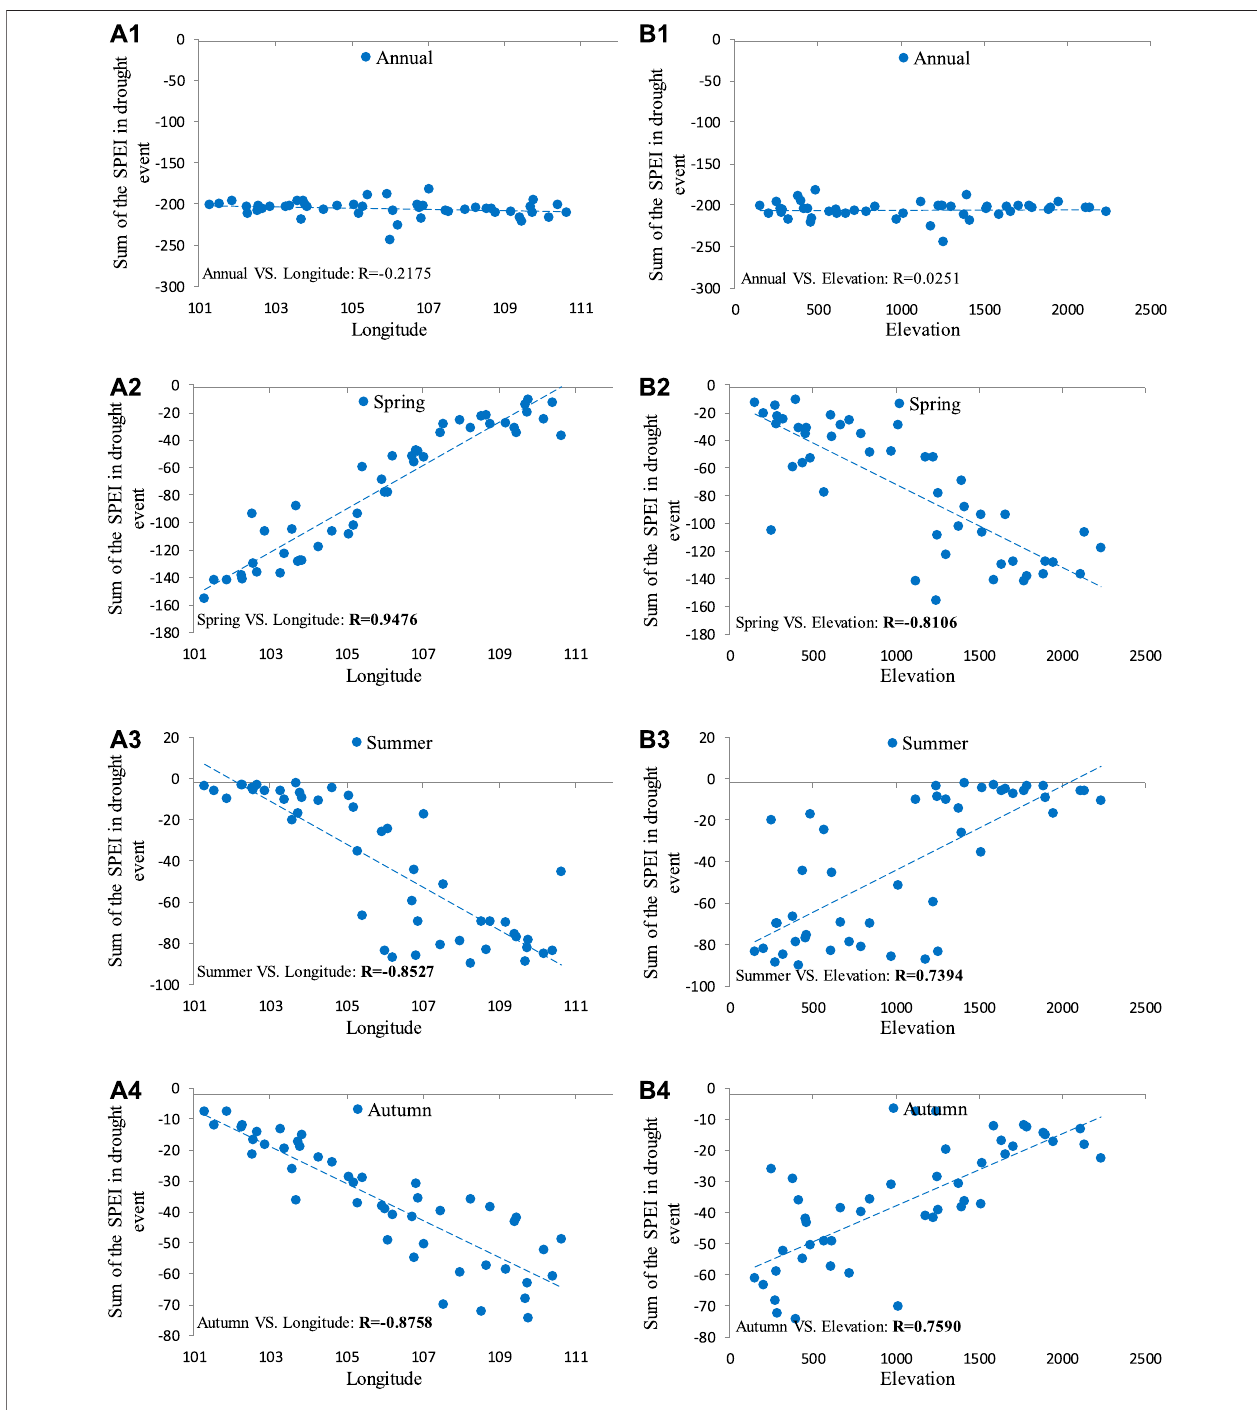
FIGURE 14 | Correlations between annual and seasonal SPEI sums of drought events and longitude and elevation. (A1 – A7) represents the correlation between drought events of annual, spring, summer, autumn, winter, rainy season, dry season and longitude; (B1 – B7) represents the correlation between drought events of annual,spring, summer, autumn, winter, rainy season, dry season and elevation. R represents the correlation coef fi cient, and the bold fonts indicate thatthe con fi dence level is α (cid:1) 0.001.